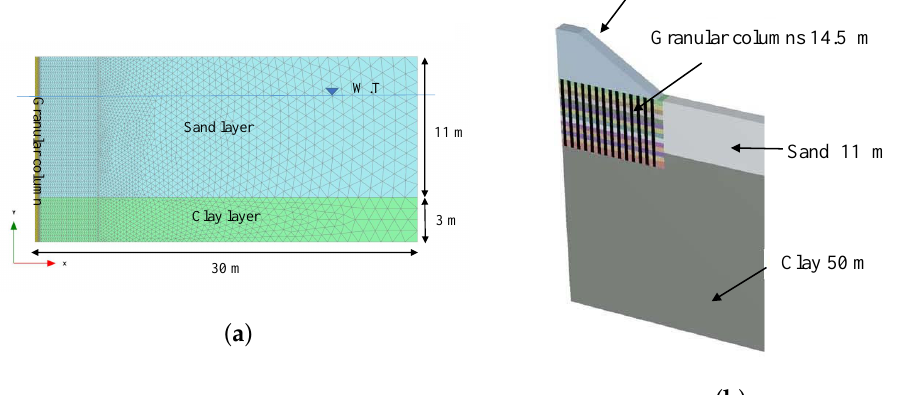
Figure 4. Numerical models: ( a ) 2D installation model; ( b ) construction 3D